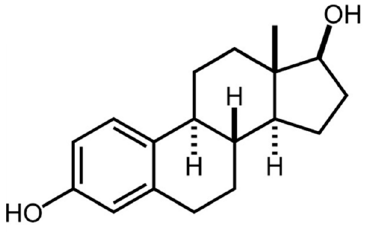
Figure 1. Chemical structure of 17 β -estradiol. Modified from Wang et al., 2006 [4].